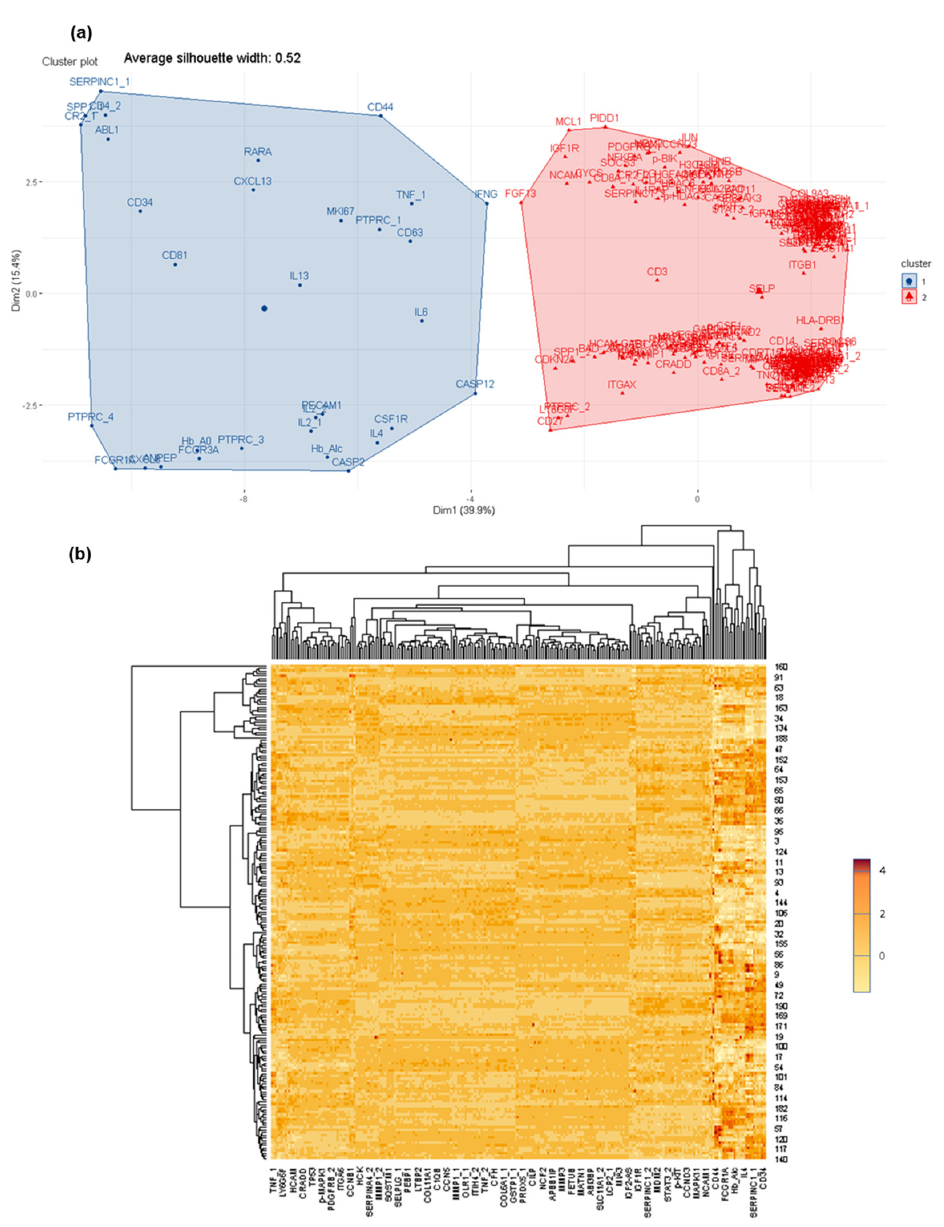
Figure 2. Differential protein profiles between CSF +/ − LM by customized protein arrays. ( a ) Differential protein profiles clustered to discriminate between CSF +/ − LM. ( b ) Heat map of protein distribution determined in this comparison.